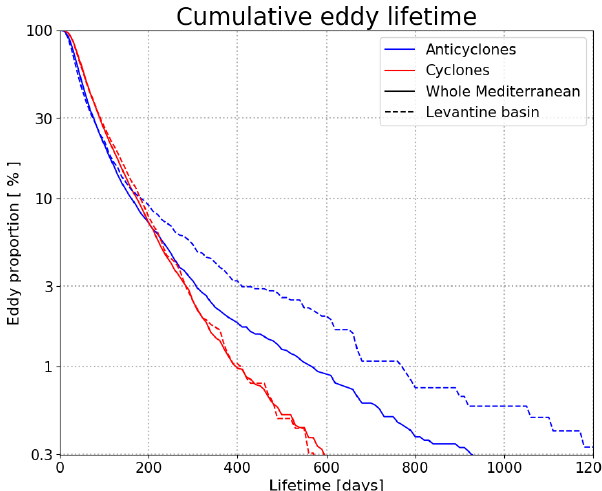
Figure 5. Cumulative eddy lifetime as a percentage on a logarithmic scale, separated for cyclones and anticyclones and for the LB and the whole Mediterranean